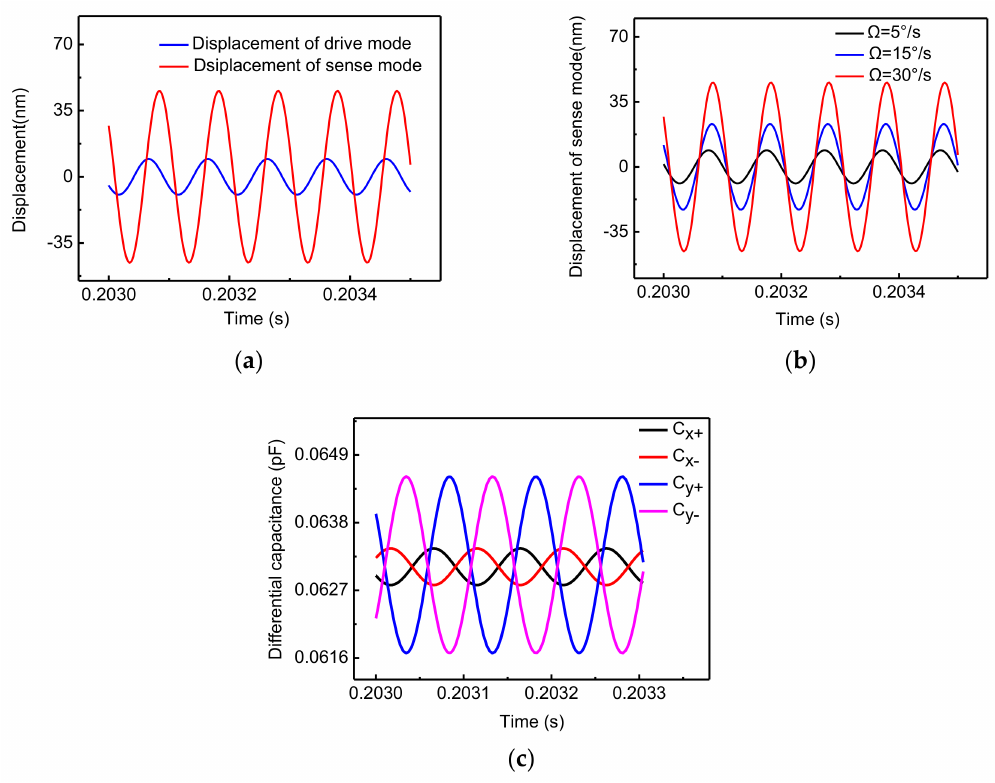
Figure 5. The simulation results of the capacitive micro-gyroscopes PSPICE model: ( a ) drive-axis displacement and sense-axis displacement, Ω = 30 ◦ /s ( b ) sense-axis displacements at different angular rates ( c ) the differential detection capacitance of drive mode and sense mode, Ω = 30 ◦ /s.